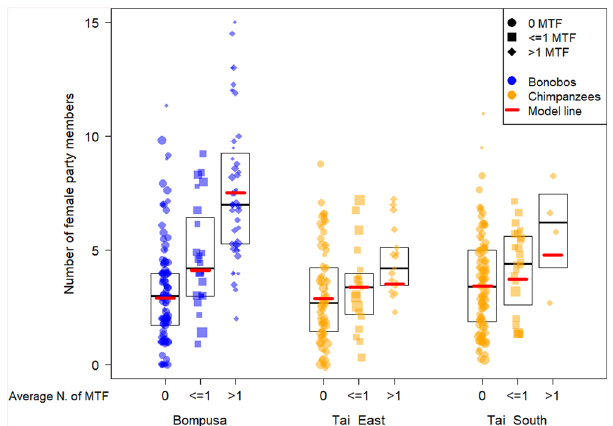
Fig. 2 Effect of the number of maximally tumescent females (MTF) on the number of females in the party of the focal female. The Bompusa bonobo community is depicted in blue and the two Taï chimpanzee communities are depicted in orange. 0 means no MTF, ≤ 1 means an average of 1 or less but not 0 MTF, and >1 means an average of more than 1 MTF were present during the focal follow [all including focal swelling]. Each dot represents a half-day focal follow and the size of the dots represents the number of data points (i.e. number of 30 min parties) for a given value. Boxes indicate the medians and the 25 and 75% quartiles. Bold red lines represent the model line controlling for food availability, dominance rank, time of the day, and multiple sampling of the same individuals (Model 3a).